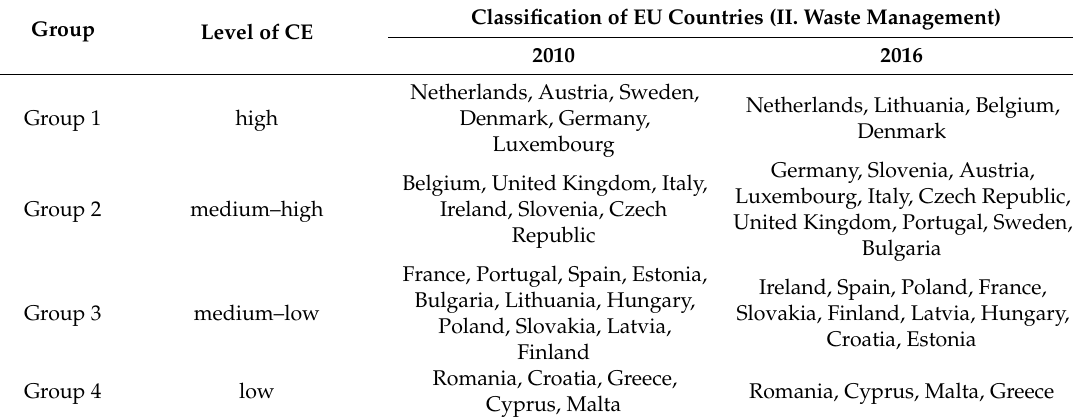
Table 6. Classification of EU countries for CE development level ( MS II Group Level of CE